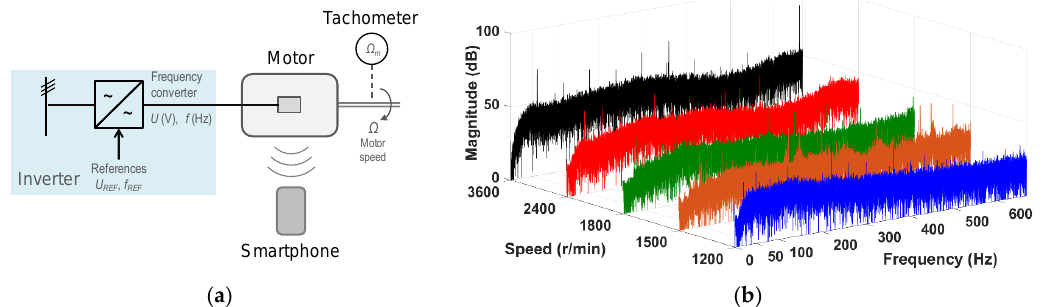
Figure 8. No load coupled to the motor shaft: ( a ) the test configuration; ( b ) the spectra of the motor noise signals. Table 7. No load coupled to the motor shaft: the rotor shaft mechanical frequency and the values of the frequencies cor- responding to the 11 peaks of the magnitude of the spectrum of the noise signal.